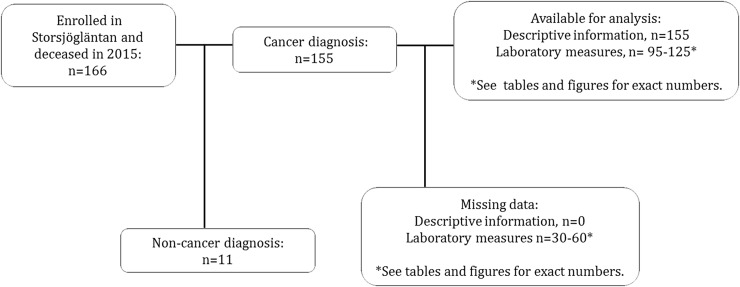
Flow of selection process.